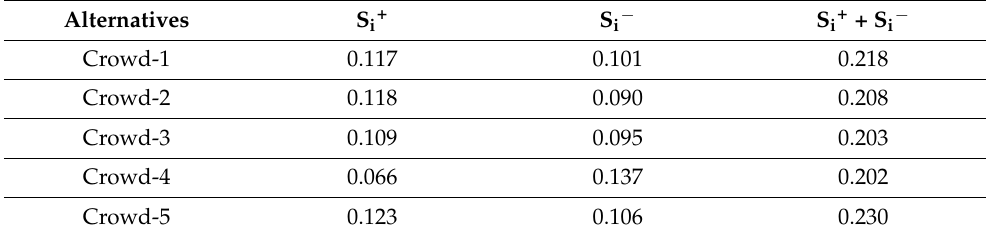
Table 10. Ideal and non-ideal separation measures.